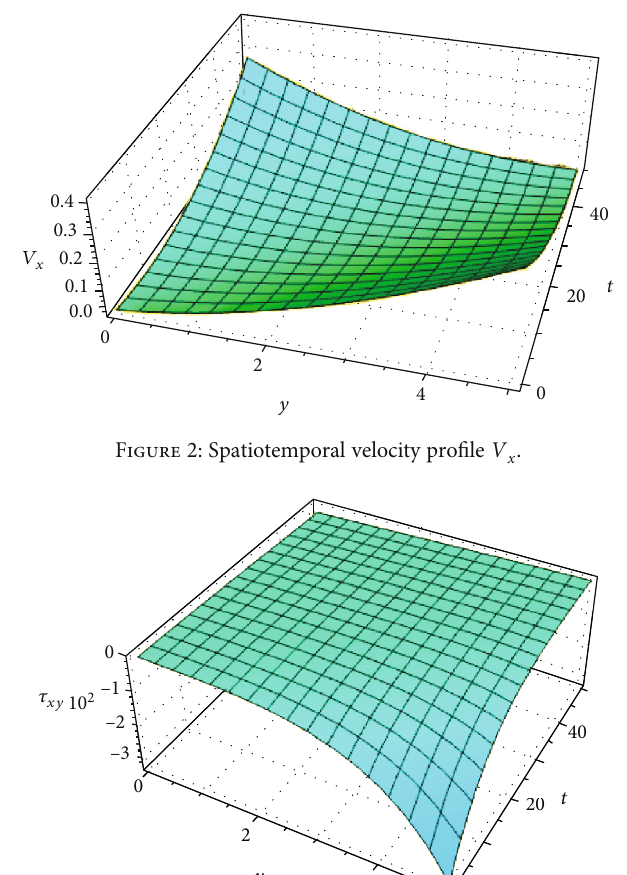
Figure 3: The shear stress τ